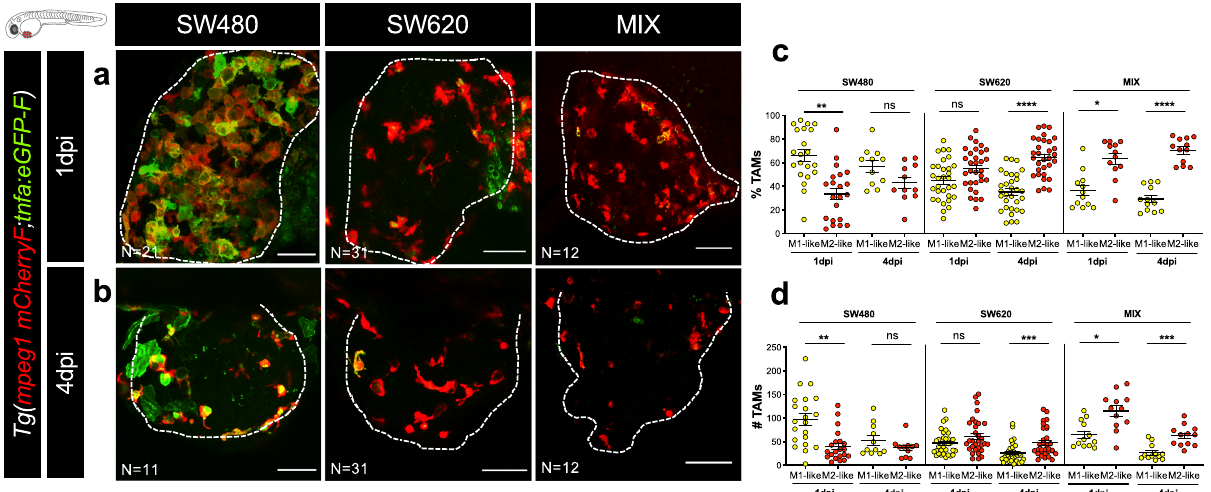
Fig. 4 SW480 and SW620 human tumor cells modulate zebra fi sh macrophage polarization. a , b Representative confocal images of SW480, SW620, and MIX xenografts injected in Tg(mpeg1:mcherry-F, tnfa:GFP-F) at 1 and 4 dpi. Red: macrophages; green: TNFa + cells; yellow: overlay of macrophages in red and TNFa + cells in green — M1-like macrophages. c Proportion of M1- and M2-like macrophages in the TME at 1 and 4 dpi (paired two-sided t test, ** P = 0.0033, ns = 0.1833, ns = 0.1160, **** P < 0.0001, *P = 0.0116, **** P < 0.0001). d Quanti fi cation of absolute numbers of M1- and M2-like macrophages in the TME at 1 and 4 dpi (paired two-sided Wilcoxon rank test ** P = 0.0016, ns = 0.3086, ns = 0.1473, *** P < 0.0002, * P = 0.0205, *** P < 0.0005). Scale bars: 50 μ m. Dashed lines encircle tumor areas. N is depicted in the images. In c and d , the number of xenografts analyzed is: SW480_1dpi N = 21, SW480_4 dpi N = 11, SW620_1 dpi N = 31, SW620_4 dpi N = 31, MIX_1 dpi N = 12, and MIX_4 dpi N = 12. Images are maximum intensity projections. Each dot represents one xenograft. Error bars indicate mean ± SEM (from 2 independent experiments in SW480, 3 in SW620, and 1 experiment for the MIX). Source data are provided as a Source data fi